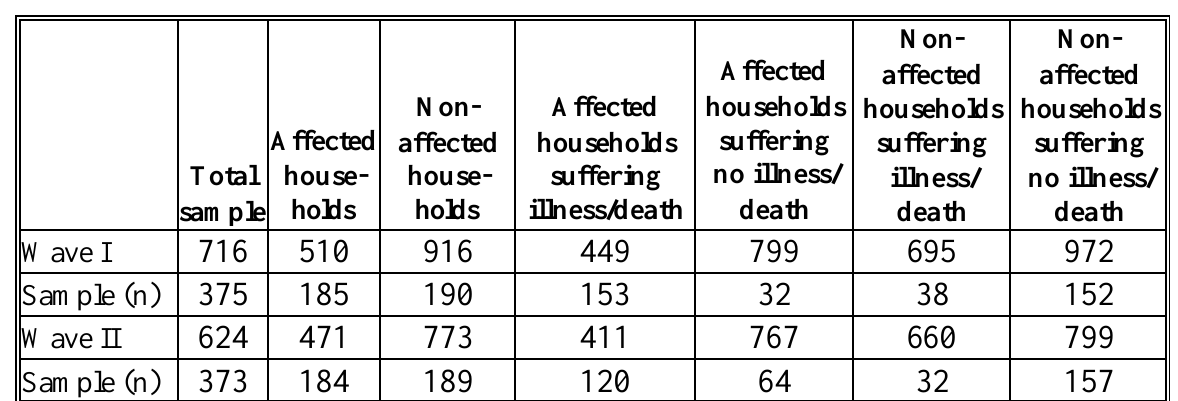
Average monthly adult equivalent per capita income for affected and non-affected households